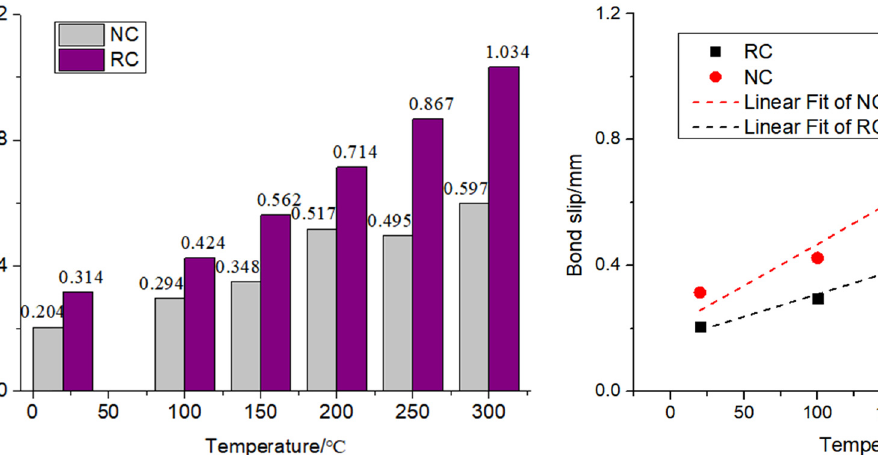
Figure 8: Linear fi tting results of bond slip.